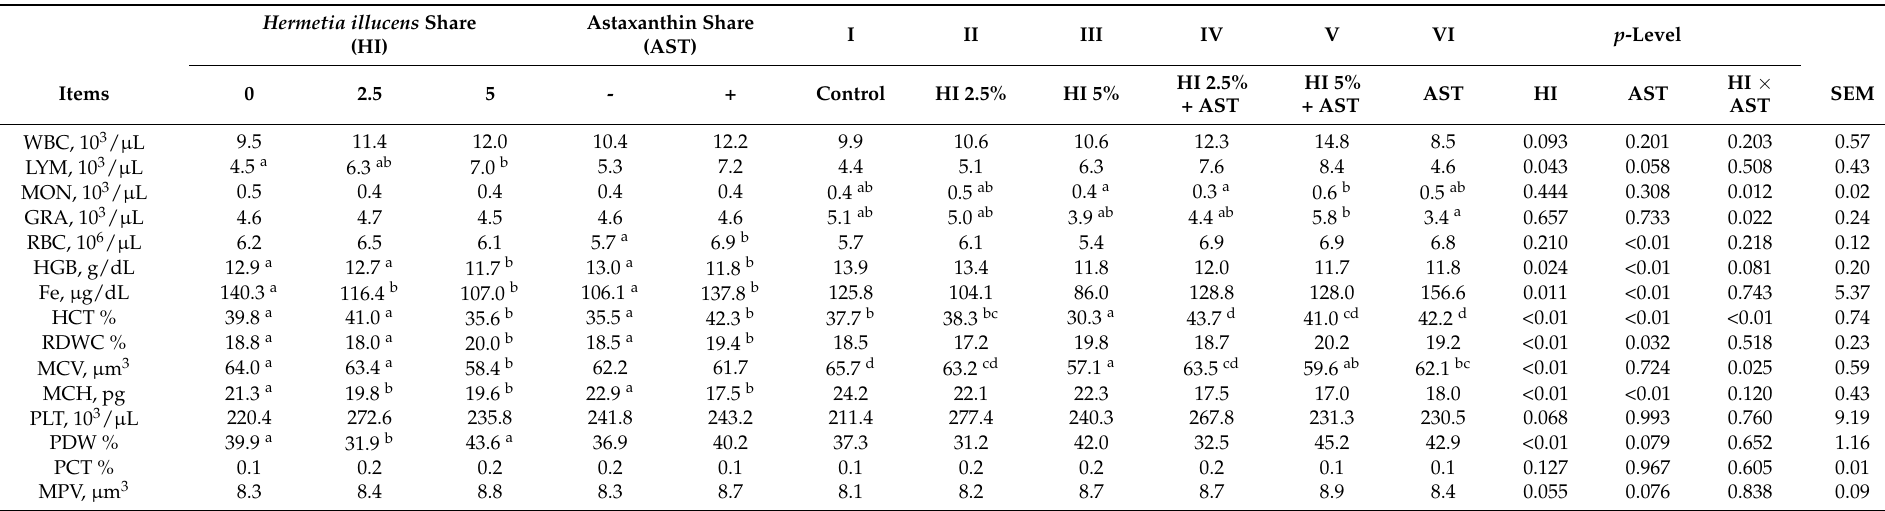
Table 5. Effect of Hermetia illucens meal share and astaxanthin presence in feed on the hematological indices of piglets’